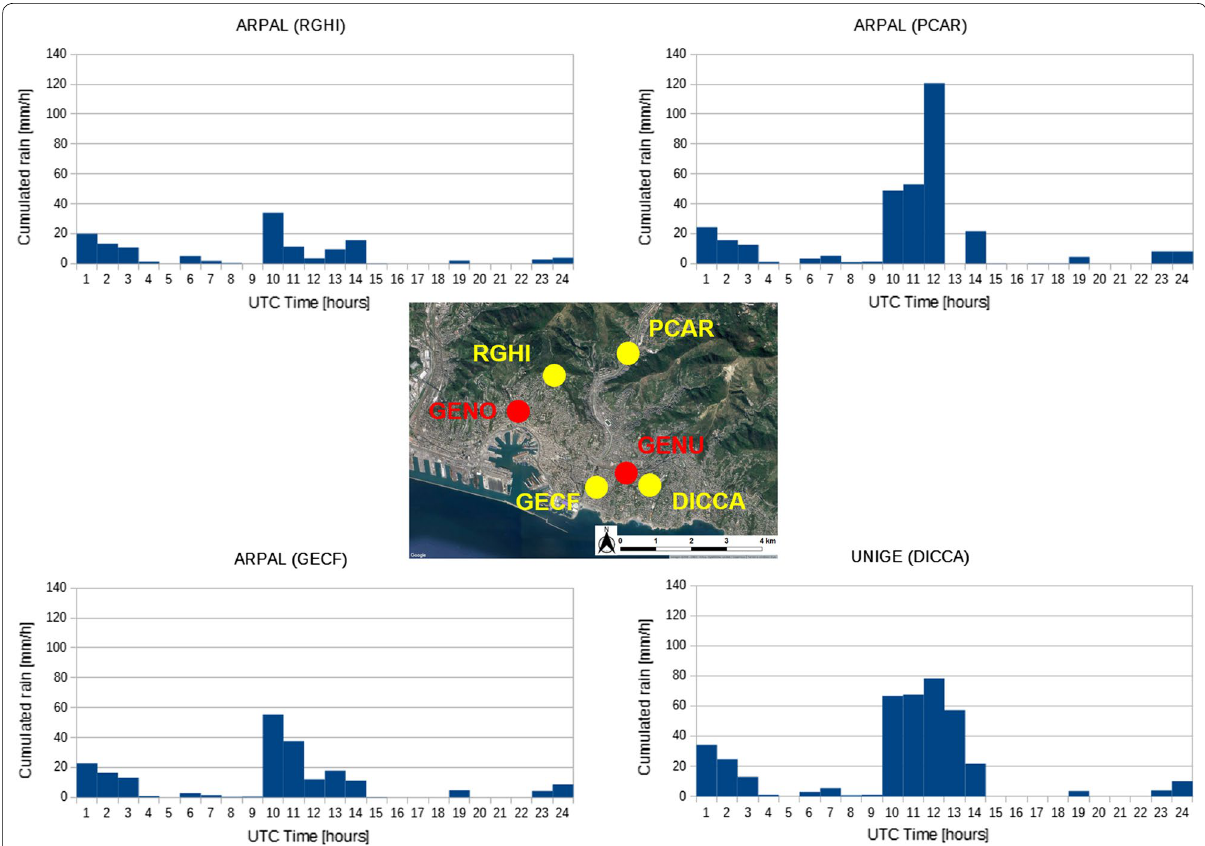
Fig. 12 Hourly cumulated rain observed by four rain gauges in the Genoa city center. The map reports the locations of the rain gauges and those of the GENO and GENU